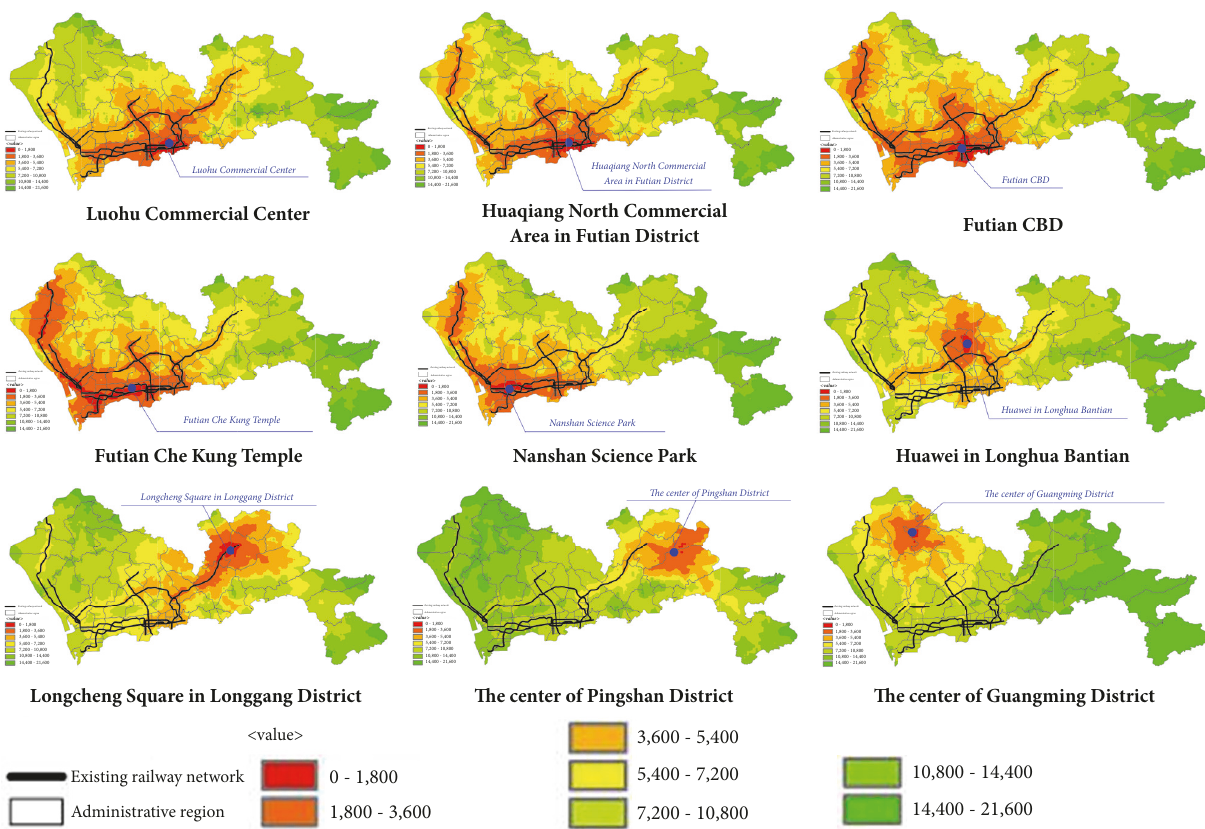
Figure 7: Shenzhen key areas public transport accessibility (unit: